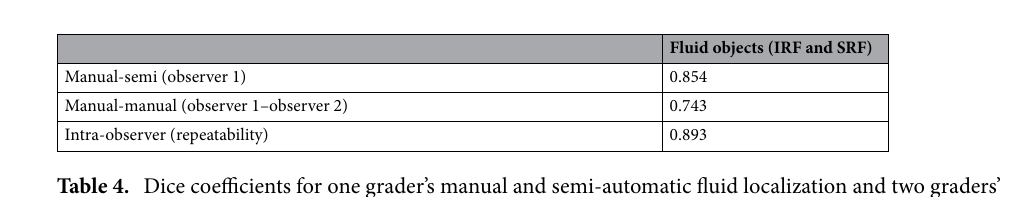
Figure 6. The Bland–Altman plots for correlating our proposed semi-automatic algorithm with the gold standard data (average of grid-manually delineated B-Scans by three examiners)—each row presents the B&A plots for each specific boundary and each column is assigned to the boundaries segmented by each examiner.